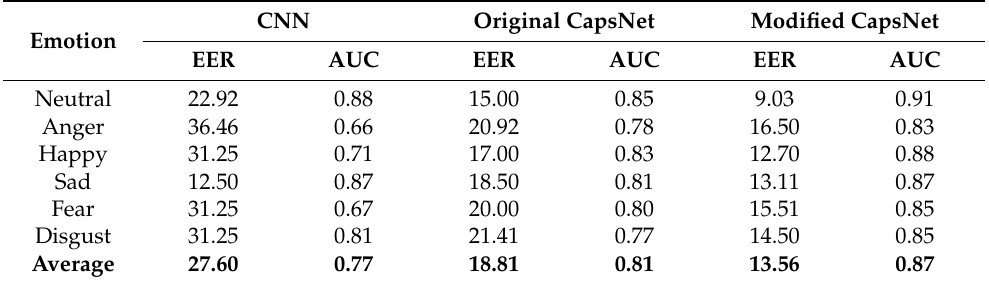
Table 8. Speaker verification performance in terms of EER and AUC of each of CNN, original CapsNet and the proposed modified CapsNet using the RAVDESS database.